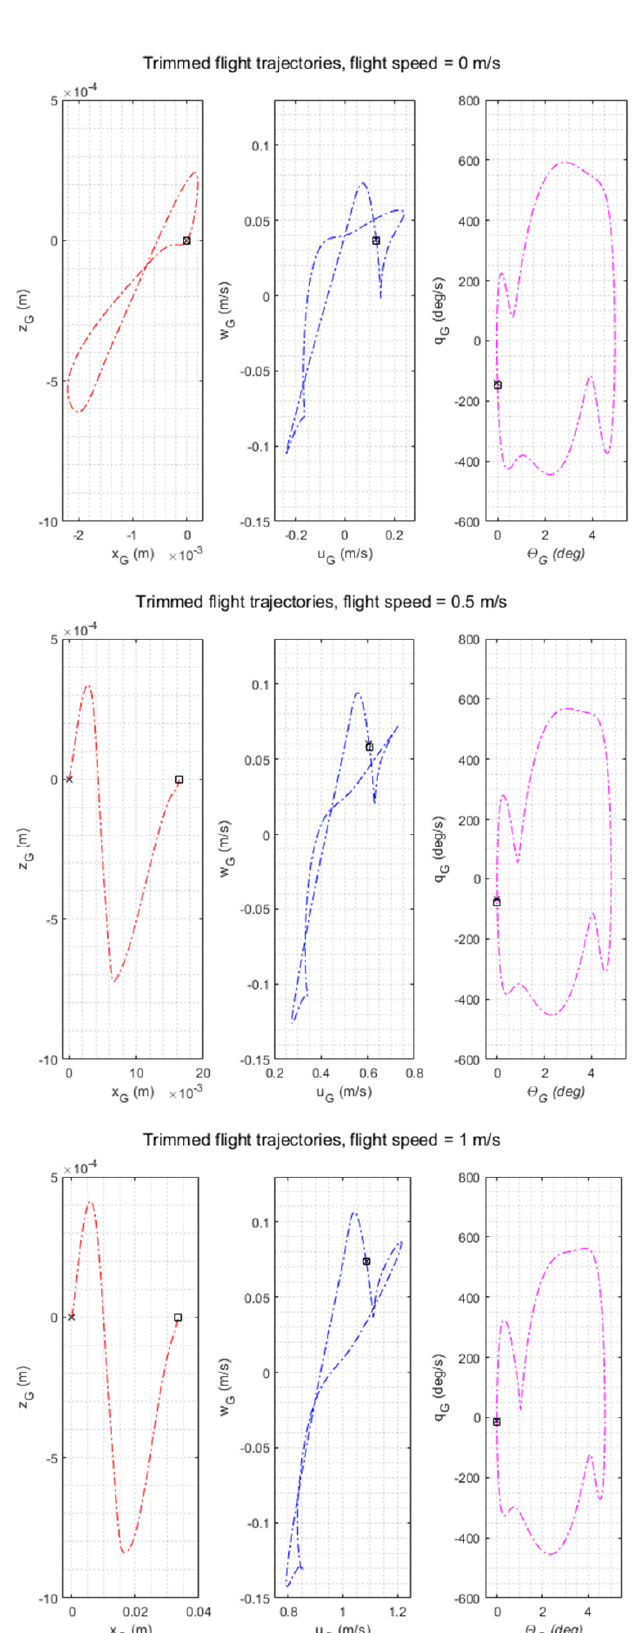
Figure 13. Trimmed flight trajectories in hovering and forward flight: the cross and square symbols indicate the initial and final points, respectively.